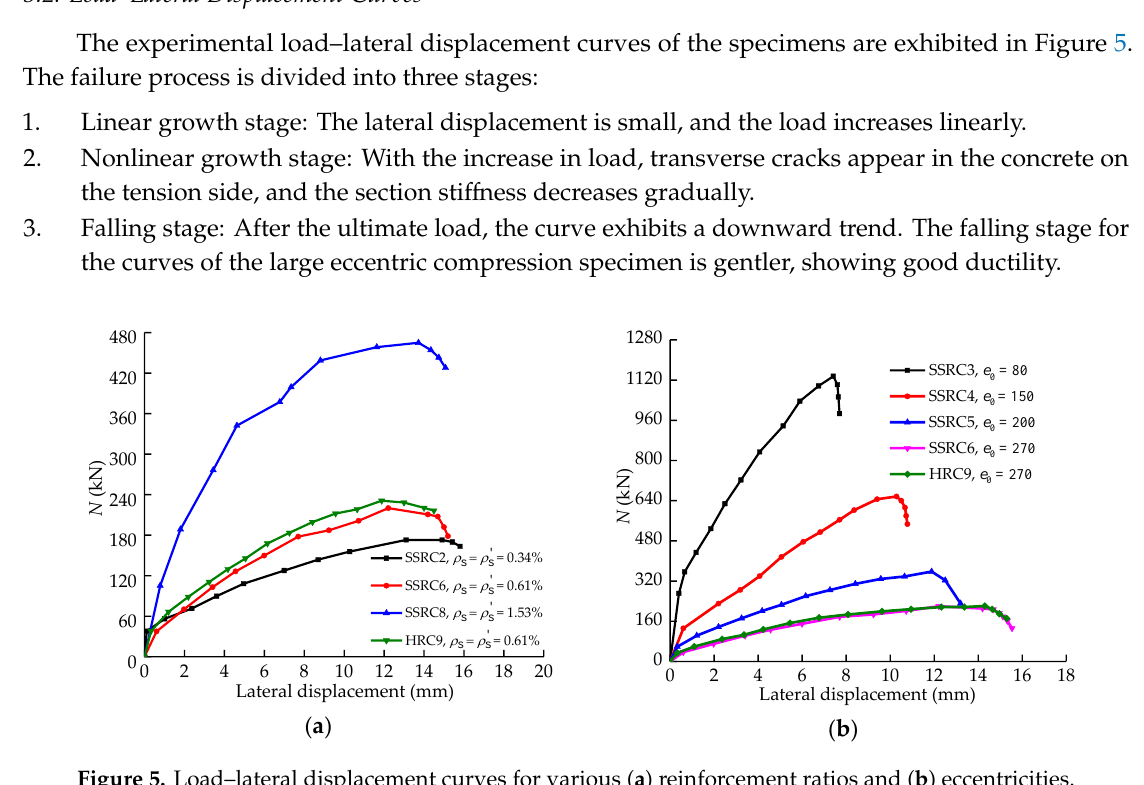
Figure 5. Load – lateral displacement curves for various ( a ) reinforcement ratios and ( b ) eccentricities.